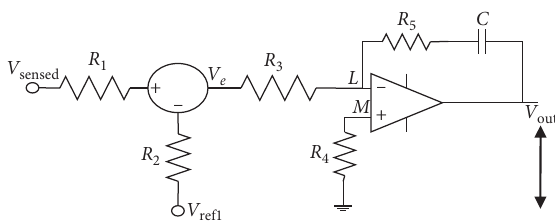
Figure 8: Circuit diagram of a proportional-plus-integral